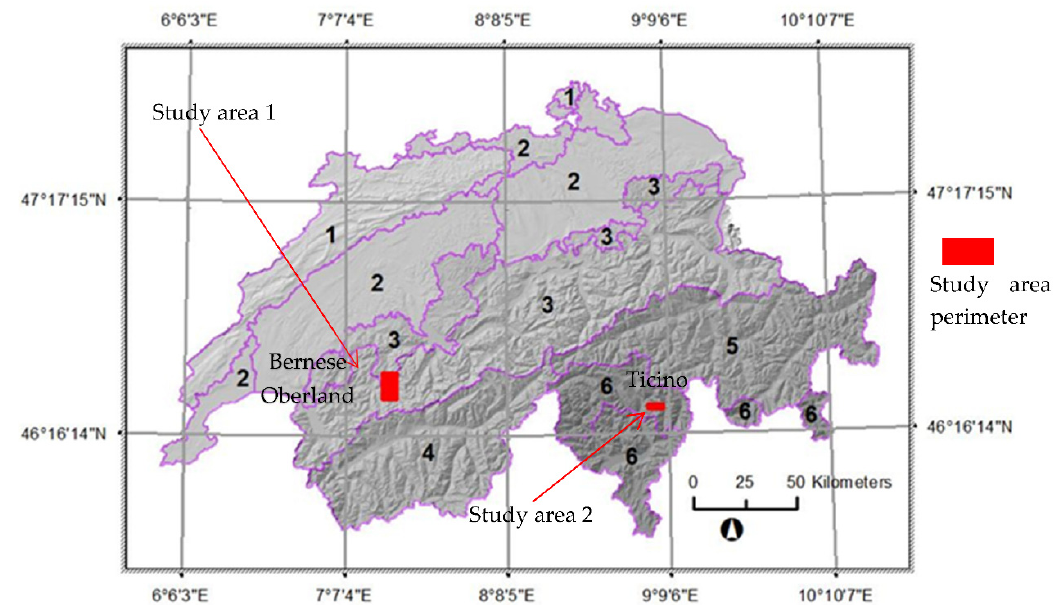
Figure 1. Shaded relief of Switzerland with the locations of the two study areas (red boxes) in the Bernese Oberland (study area 1) and Ticino (study area 2). The number represents biogeographical regions of Switzerland: (1) Jura; (2) Central Plateau; (3) Northern Alps; (4) Western Central Alps; (5) Eastern Central Alps; (6) Southern Alps.